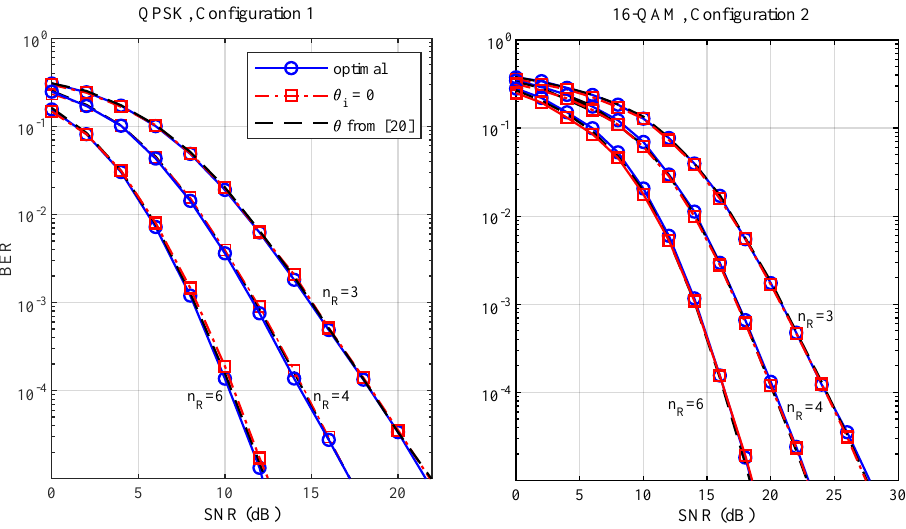
Figure 4. BER of MA-SM using the optimal rotation angles, the angles derived in [20], and the all-zero angle set, for N T = 4, N P = 2, n R = 3, 4, and 6, using QPSK ( left sub-figure ) and 16-QAM ( right-sub-figure